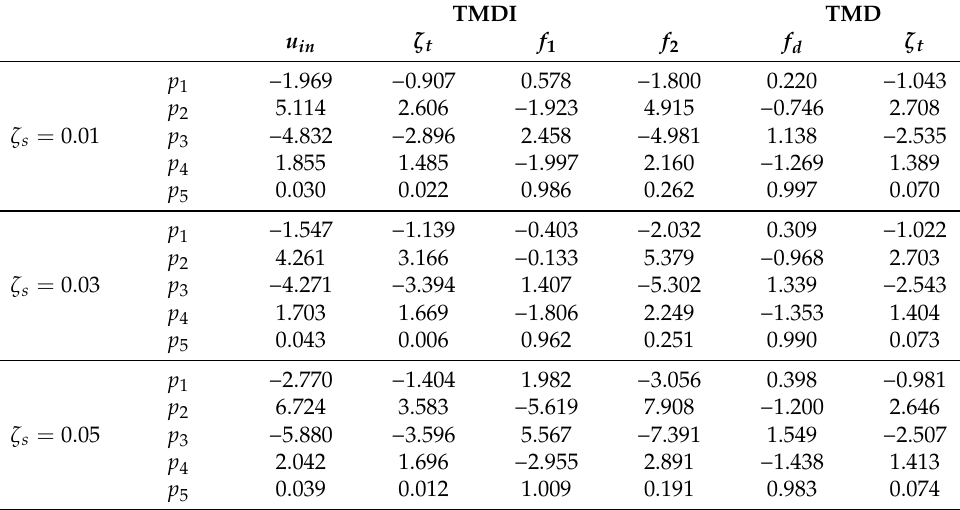
Figure 4. The optimal design parameters of TMDI with the various mass ratios u t : ( a ) Inertance - mass ratio u in ; ( b ) Damping ratio ζ d ; ( c ) Tuning frequency f 1 ; ( d ) Tuning frequency f 2 . Table 1. The coefficient of the polynomial for the optimal